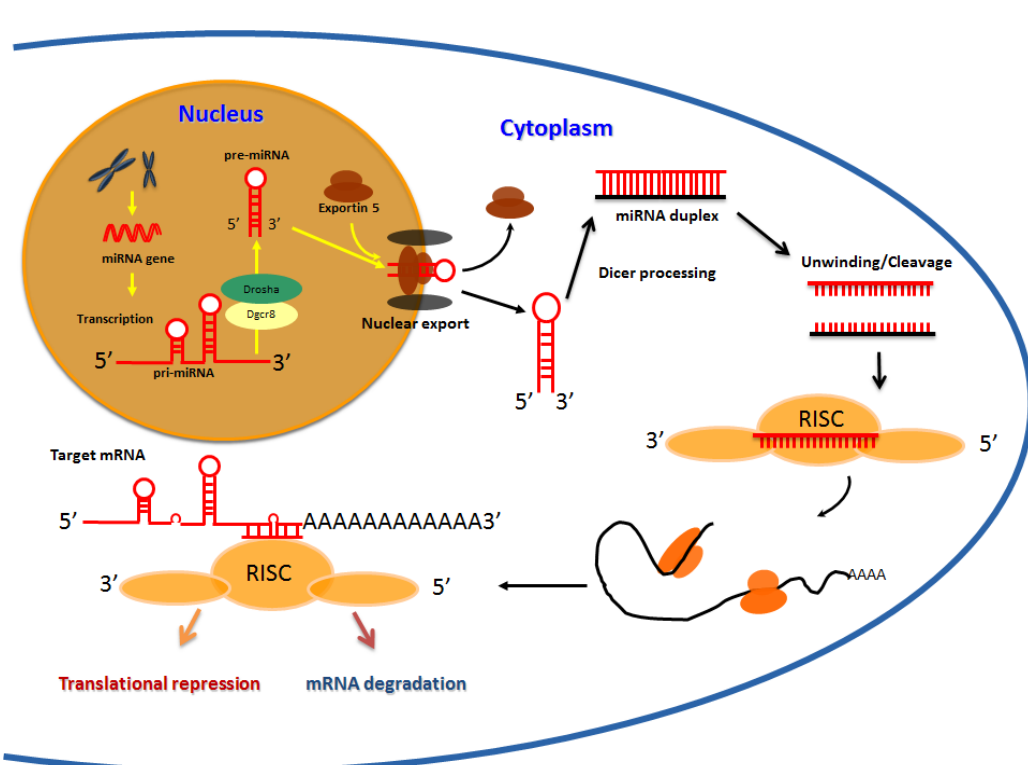
Figure 1. MicroRNA biogenesis: Schematic representation of the events during miRNA biogenesis. The miRNA genes often located in intergenic region are transcribed by RNA polymerase II into local hairpin structures called primary microRNAs (pri-miRNAs) which are then processed to pre-miRNAs by Drosha and Pasha in the cell nucleus. After exportation in the cytoplasm, a ~22 nt duplex is formed due to Dicer processing in association with other cofactors. Mature miRNAs recognize seed sequences in the 3' UTRs of target mRNAs and repress gene expression by either destabilizing target mRNAs or repressing their